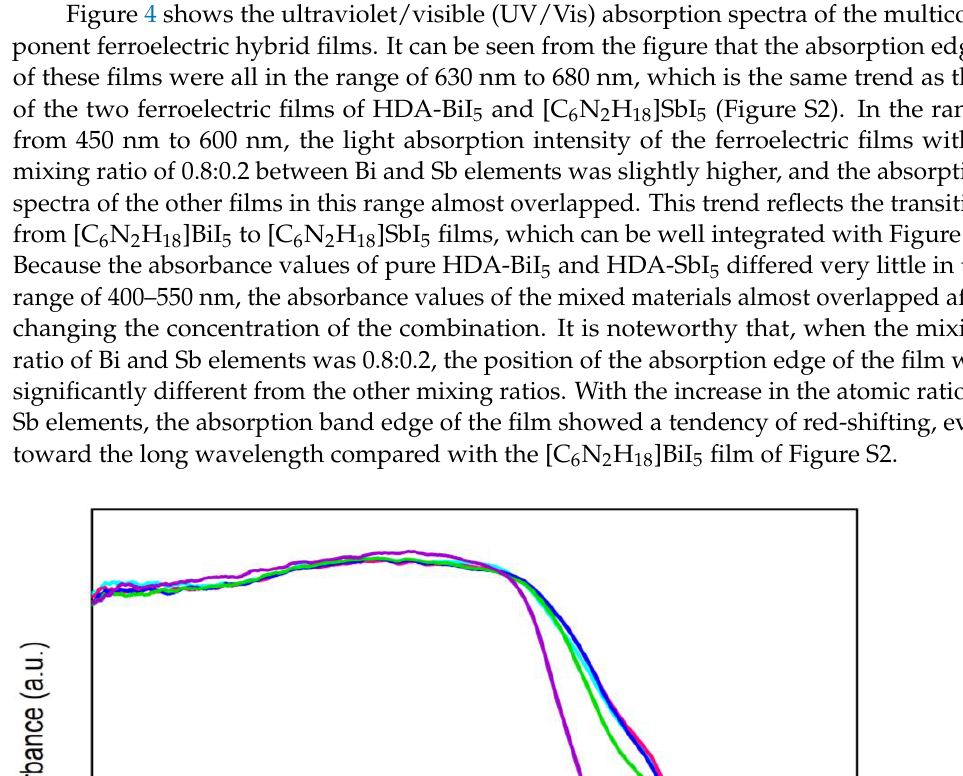
Figure 3. SEM top view of the multicomponent ferroelectric hybrid films. ( a , c , e , g , i ) are the ferroe- lectric films formed by [C 6 N 2 H 18 ]BiI 5 and [C 6 N 2 H 18 ]SbI 5 mixing ratios of 0.8:0.2, 0.6:0.4, 0.5:0.5, 0.4:0.6 and 0.2:0.8, in that order. ( b , d , f , h , j ) are enlarged views of ( a , c , e , g , i ), respectively.